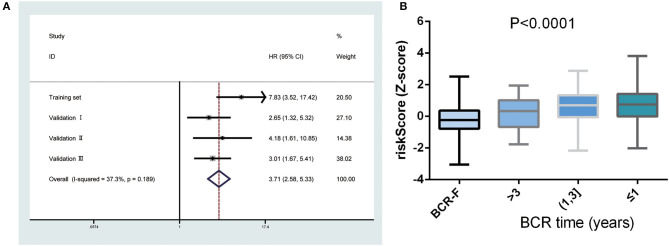
Predictive value of gene signature for biochemical recurrence (BCR) in the pooled cohort. (A) Meta-analysis showing that high-risk score yielded a worse recurrence-free survival (RFS). (B)
Z-scores in BCR-free patients were significantly lower than those in BCR patients and had a tendency to increase gradually with the extension of BCR time.